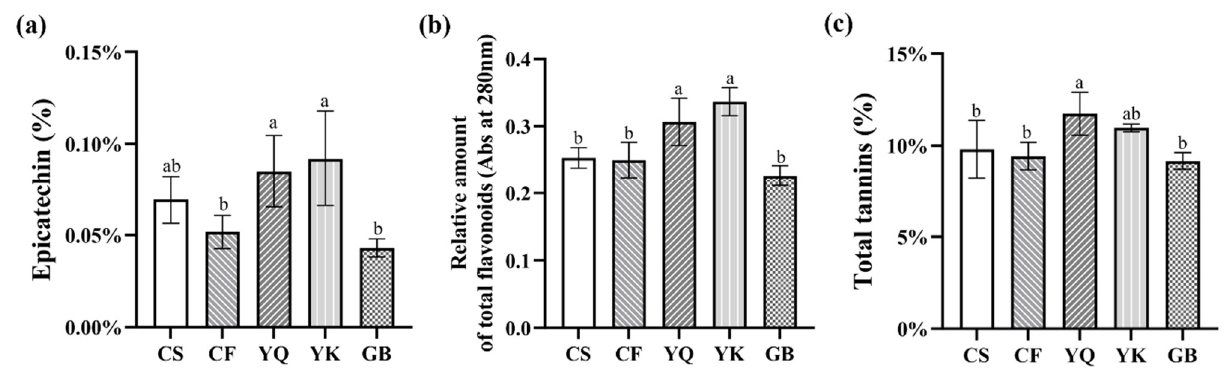
Figure 1. Content of active components in Fagopyri Dibotryis Rhizome (FDR) from different producing areas. ( a ) Epicatechin content of FDRs. ( b ) Total flavonoid content of FDRs. ( c ) Total tannin content of FDRs. The a, b, c above the bar chart indicates the difference significance; and the two comparison groups with no significant difference were marked with the same letter; The significance value was a > ab > b.